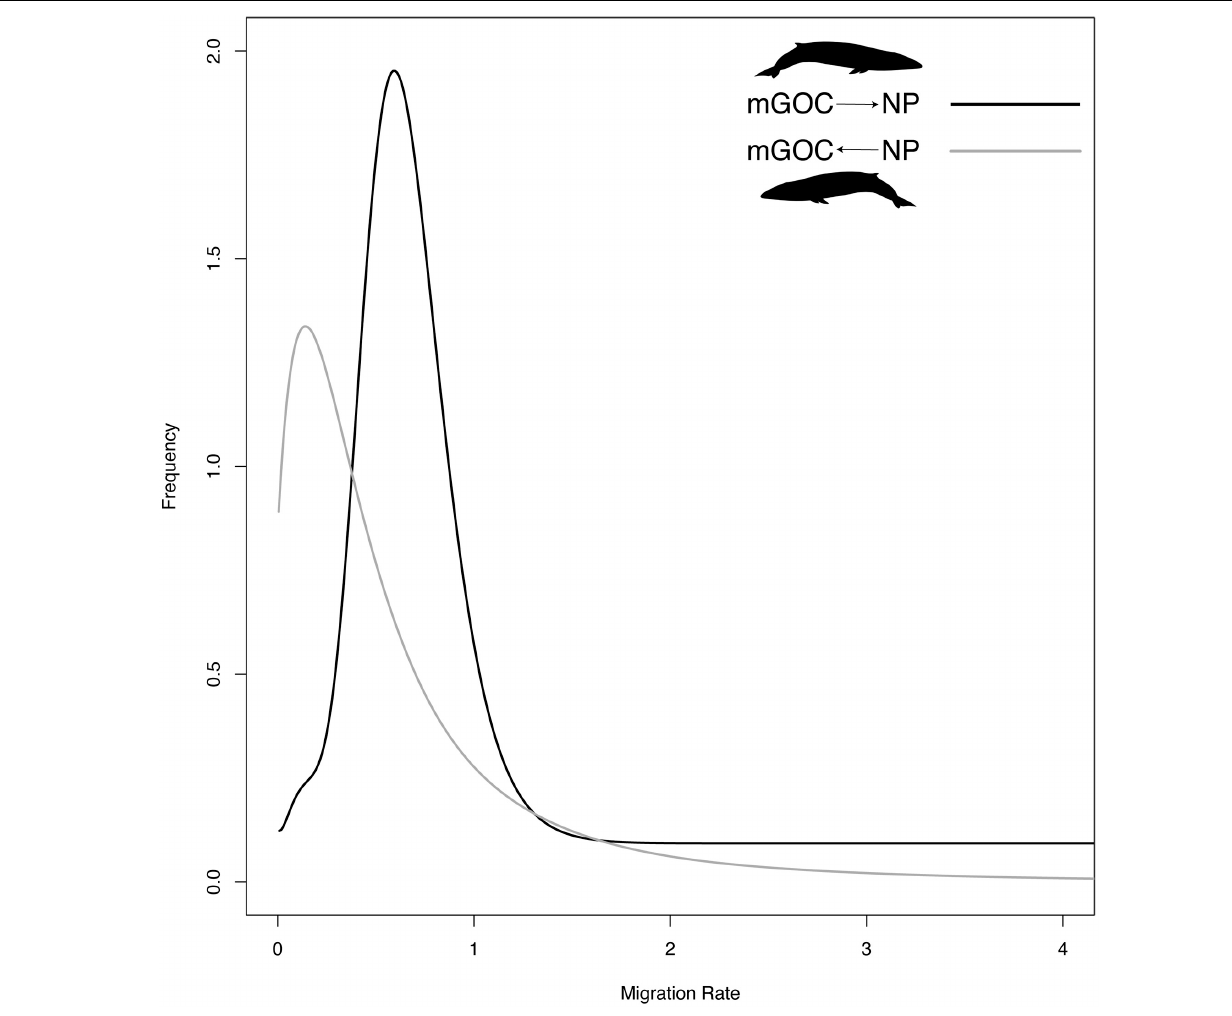
FIGURE 4 | Marginal posterior probability distribution (frequency) of asymmetric migration rate estimates of GoC and NP, using an Isolation with Migration model implemented in